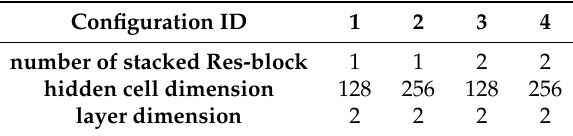
Table 7. Hybrid ResNet-LSTM configuration sets.